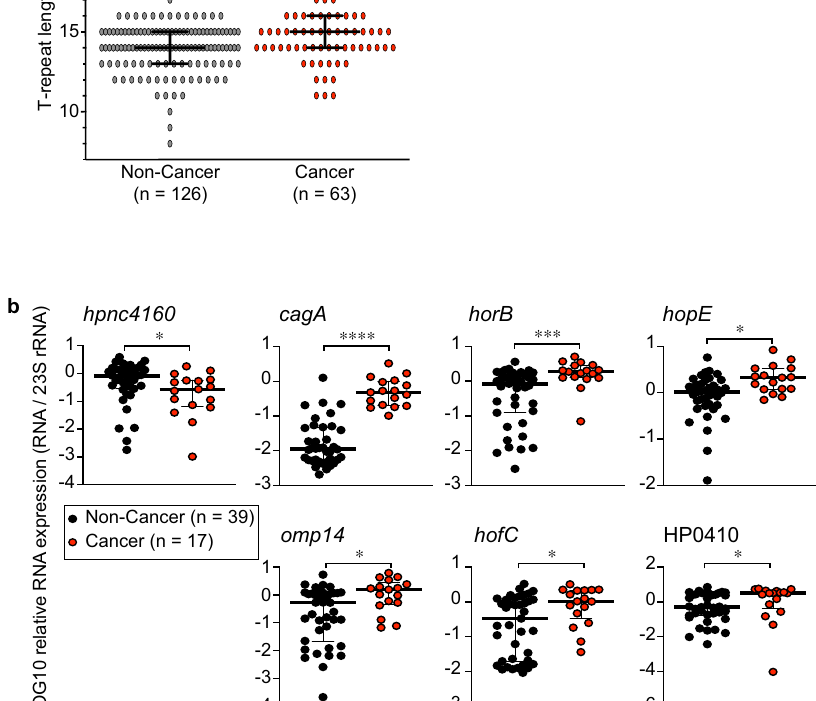
Fig. 6 T-repeat length and HPnc4160 expression in clinical isolates. a , b T-repeat length upstream of HPnc4160 ( a ) and expression of indicated mRNAs ( b ) in clinical isolates from non-cancer (non-cancer) and patients with cancer (cancer). Data are presented as means with 95% con fi dence interval ( a ) or medians with interquartile range ( b ). Statistical signi fi cance determined by two-tailed Mann – Whitney test ( a , b ). * P = 0.0157 ( a ); * P = 0.0215 ( hpnc4160 ), **** P < 0.0001 ( cagA ), *** P = 0.0004 ( horB ), * P = 0.0025 ( hopE ), * P = 0.0110 ( omp14 ), * P = 0.0122 ( hofC ), * P = 0.0205 (HP0410) ( b ). Source data are provided as a Source Data fi